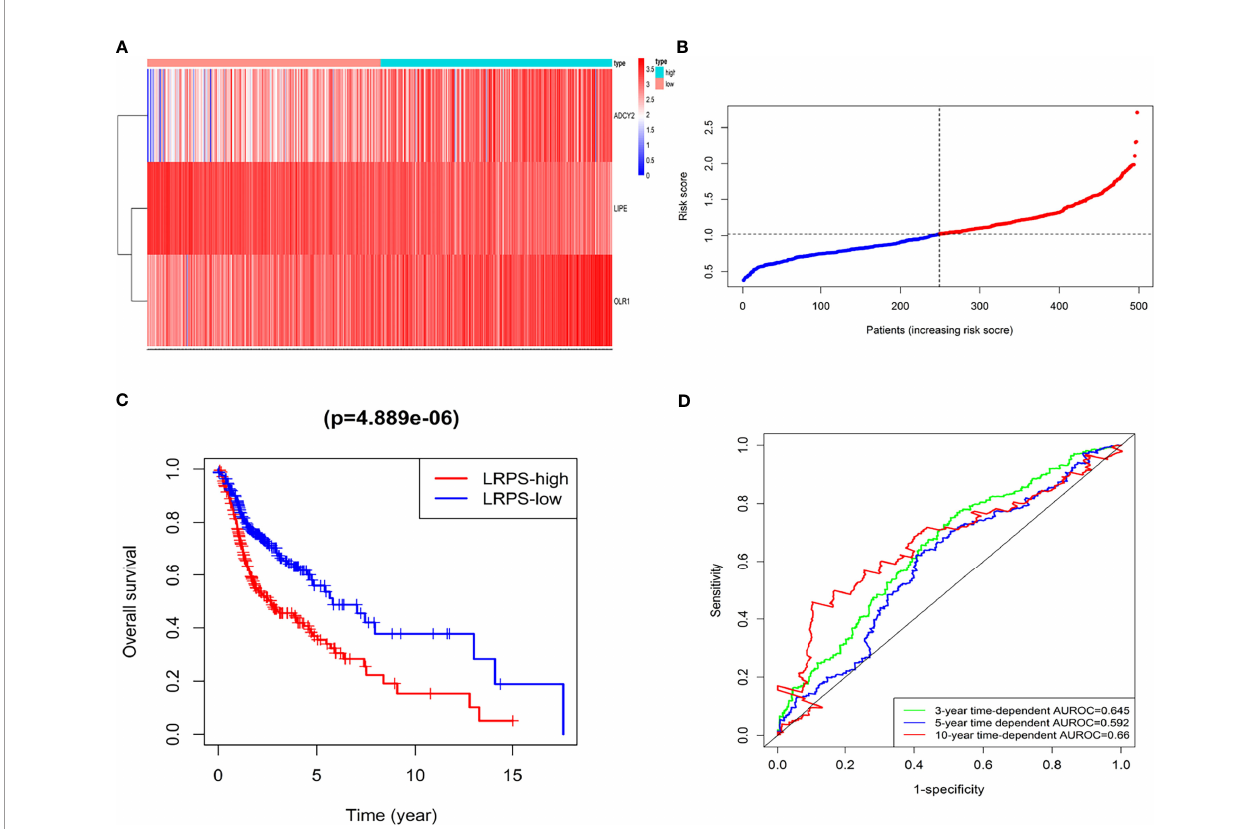
FIGURE 4 | LRPS in the TCGA model dataset. (A) Heatmap for the mRNA expression distribution in TCGA cohort by risk score, with red representing high expression and blue representing low expression. (B) The risk scores for patients with HNSCC were plotted in ascending order. (C) The survival rates of HNSCC patients between the LRPS-high group and LRPS-low group ( p = 4.889 × 10 − 6 ). (D) C-index values of ROC